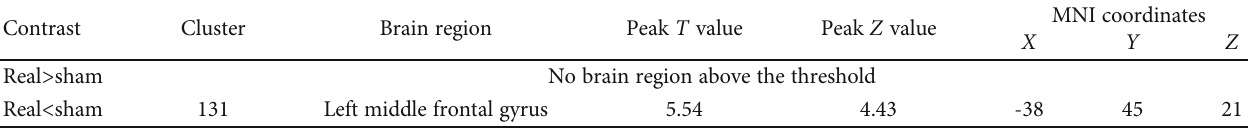
MNI coordinates X